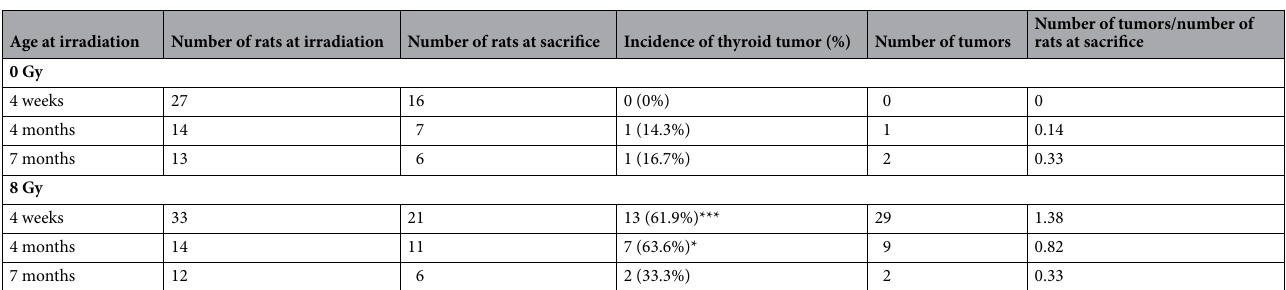
Table 1. Incidence of thyroid tumors in irradiated and non-irradiated rats. * p < 0.05, *** p < 0.001vs. non- irradiated 4W or 4M